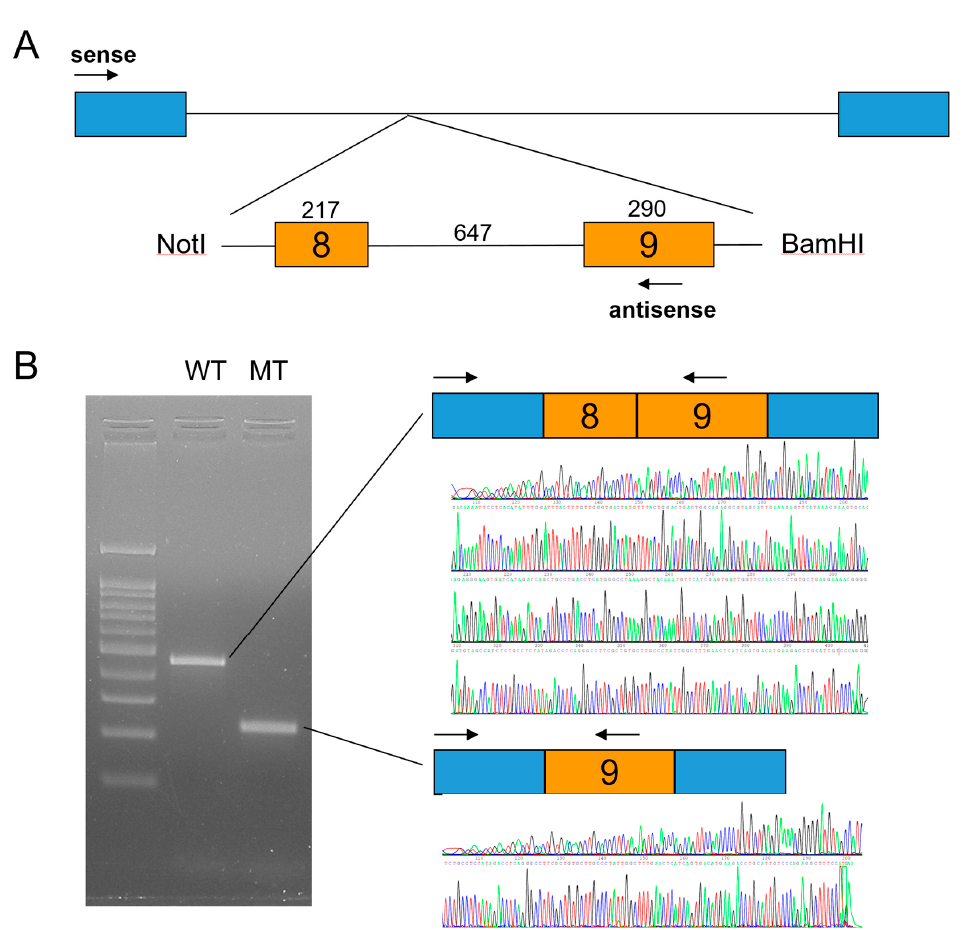
Figure 3. In vitro splicing assay. ( A ) Minigene cloning strategy. A genomic fragment including exons 8 and 9 of LRP6 was subcloned into the pSPL3 vector with double digestion using NotI and BamHI restriction endonucleases. Boxes indicate exons, and horizontal lines indicate introns. The number of the exon is in the box, and the length of the exon and intron is shown above the boxes and line. Locations of the primer binding site are indicated with arrows (sense and antisense). ( B ) Agarose gel image of the splicing assay of the wild type (WT) and mutant (MT). Left lane is the DNA ladder. Wild-type and mutant names are shown above the gel image. Wild-type vector resulted in a normal splicing product including exons 8 and 9. Mutation (c.1762+2T>C) resulted in an exon 8 deletion. Sequencing chromatograms of the alternative splicing band are shown below.